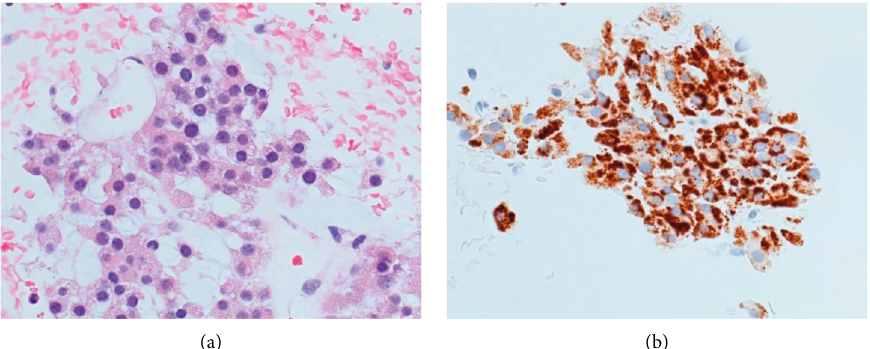
Figure 8: Photomicrograph of liver mass biopsy of Patient B. (a) Tumor cells with round nuclei and finely vacuolated cytoplasm that were arranged in anastomosing cords with delicate vasculature, resembling the previous left adrenal tumor (Figure 6) (H&E × 400). (b) Im- munohistochemical staining showed diffuse positivity for Melan A.